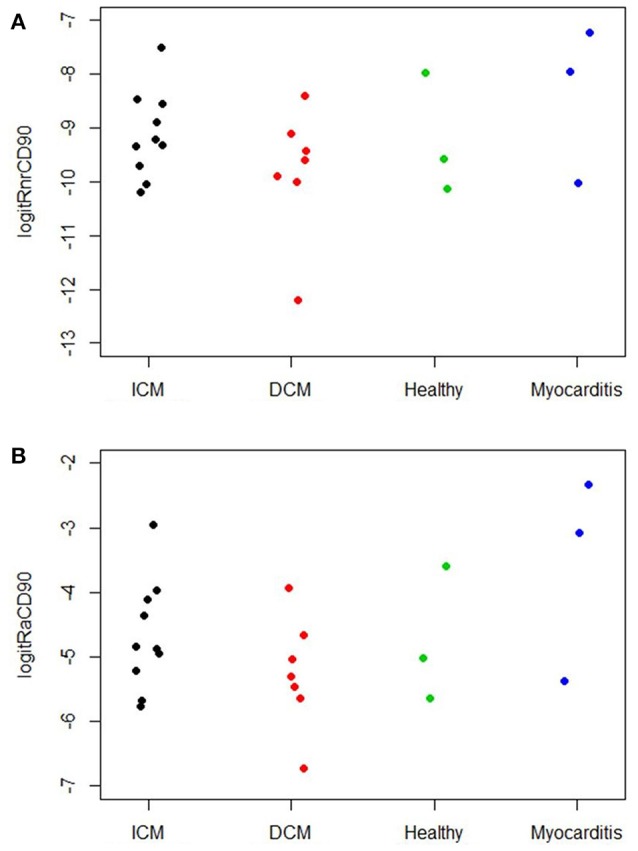
(A) Relative number of CD90+ cells per tissue section (n = 23). The X axis designates the patient groups: ICM (n = 10), DCM (n = 7), Healthy (n = 3), and Myocarditis (n = 3). The Y axis presents the relative number of CD90+ signals (total number of signals divided by total area of tissue section; Table 2), converted to the logit scale [logit(p) = log (p/(1 – p))]. Individual values of the patients are presented as spots. (B) Relative area of CD90 per tissue section (n = 23). The X axis designates the patient groups: ICM (n = 10), DCM (n = 7), Healthy (n = 3), and Myocarditis (n = 3). The Y axis presents the relative area of CD90+ signals (total area of signals divided by total area of tissue section; Table 2), converted to logit scale [logit(p) = log (p/(1 – p))]. Individual values are presented as spots.